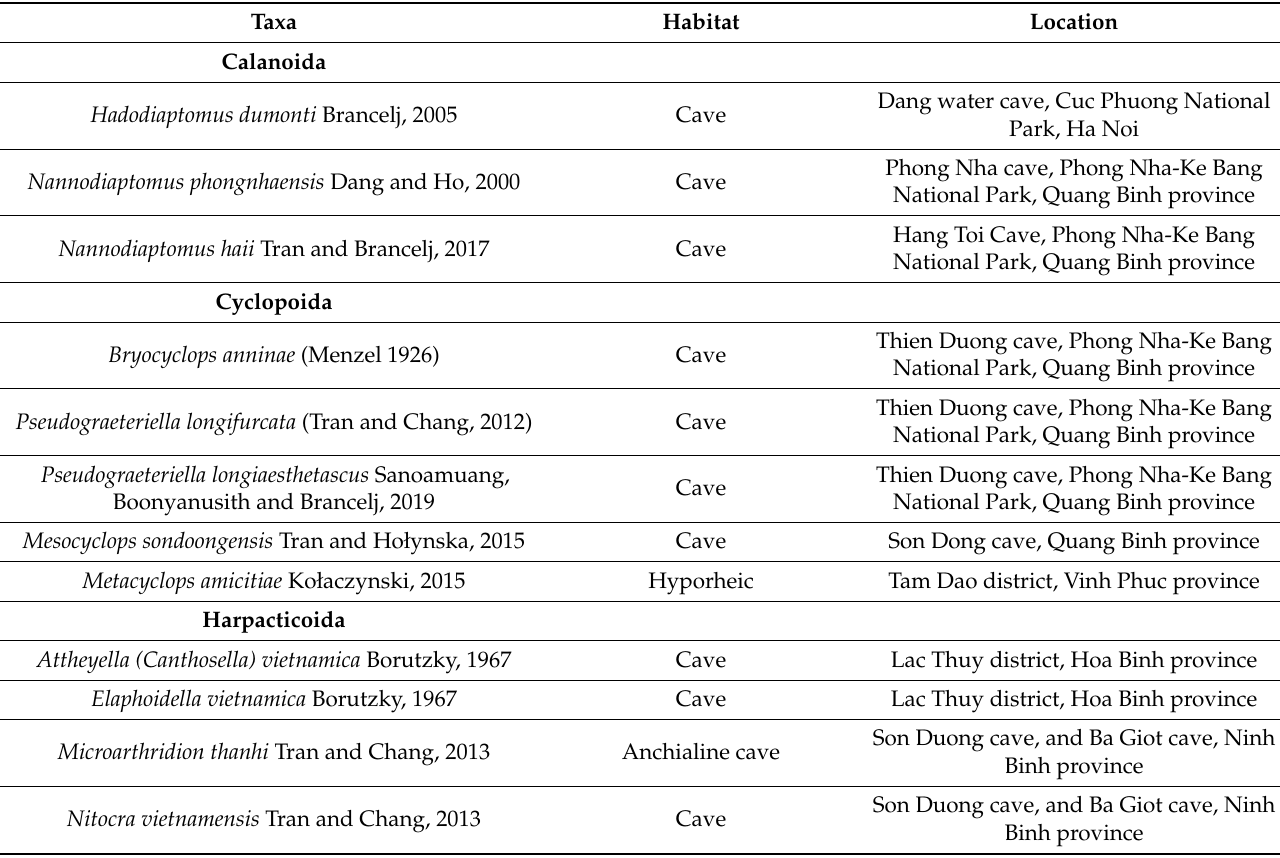
Table 1. List of stygobiotic Copepoda in